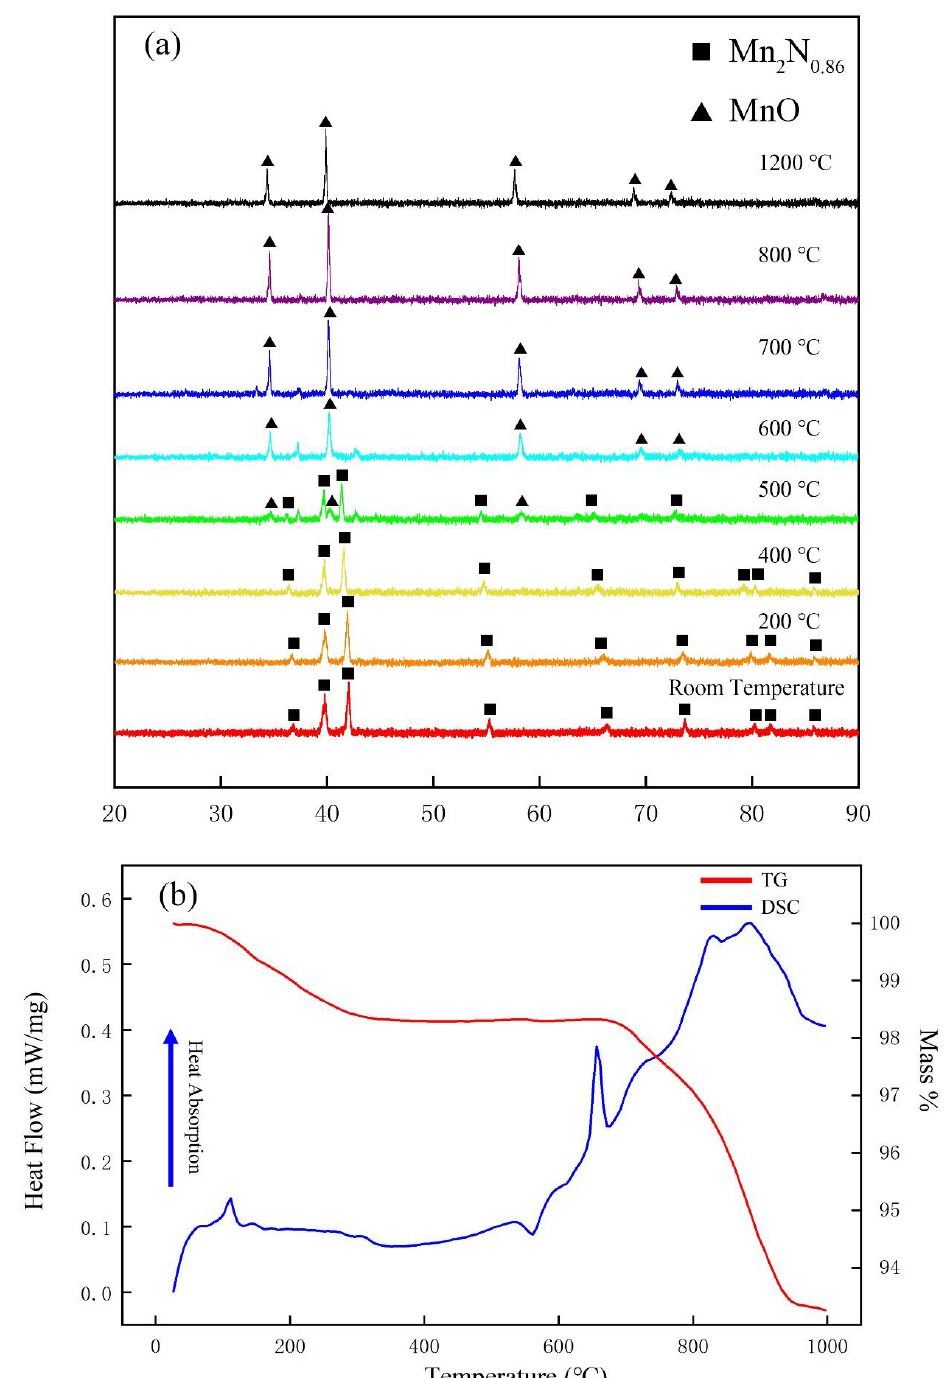
Figure 5. Variable-temperature XRD test data and TG-DSC test data of the samples. ( a ) Variable- temperature XRD test data: The black rectangles mark the Mn 2 N 0.86 characteristic peaks, and the black triangles mark the MnO characteristic peaks. ( b ) TG-DSC curve of the sample: The red line is the TG curve, and the blue line is the DSC curve.